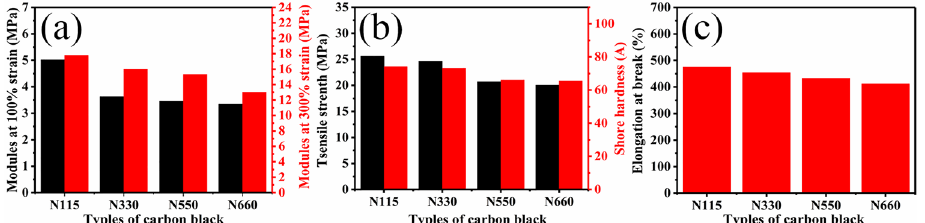
Figure 4. Mechanical properties of the CB (N115, N300, N550, and N660)-filled NR samples. ( a ) The 100% and 300% modulus values of the various CB-filled NR. ( b ) Tensile strength and hardness of the rubber filled with the various CB-filled NR. ( c ) Elongation at break of the rubber filled with the various CB-filled NR.